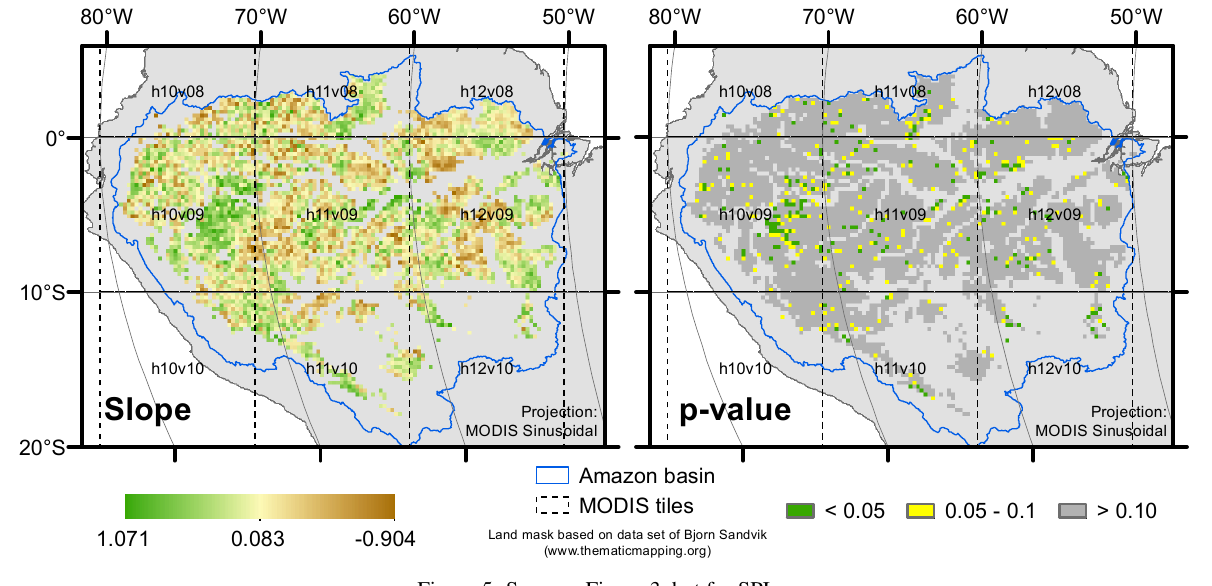
Figure 5: Same as Figure 3, but for SPI.